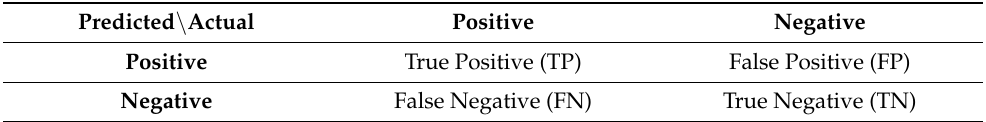
Table 1. Example of a confusion